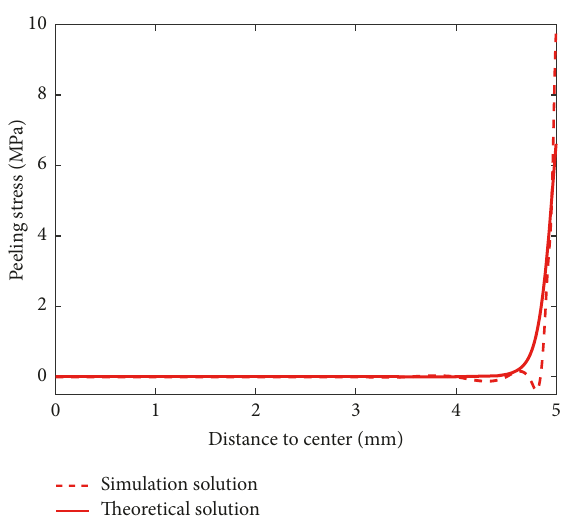
Figure 4: Theoretical solution and simulation solution distributions of the shearing stress.